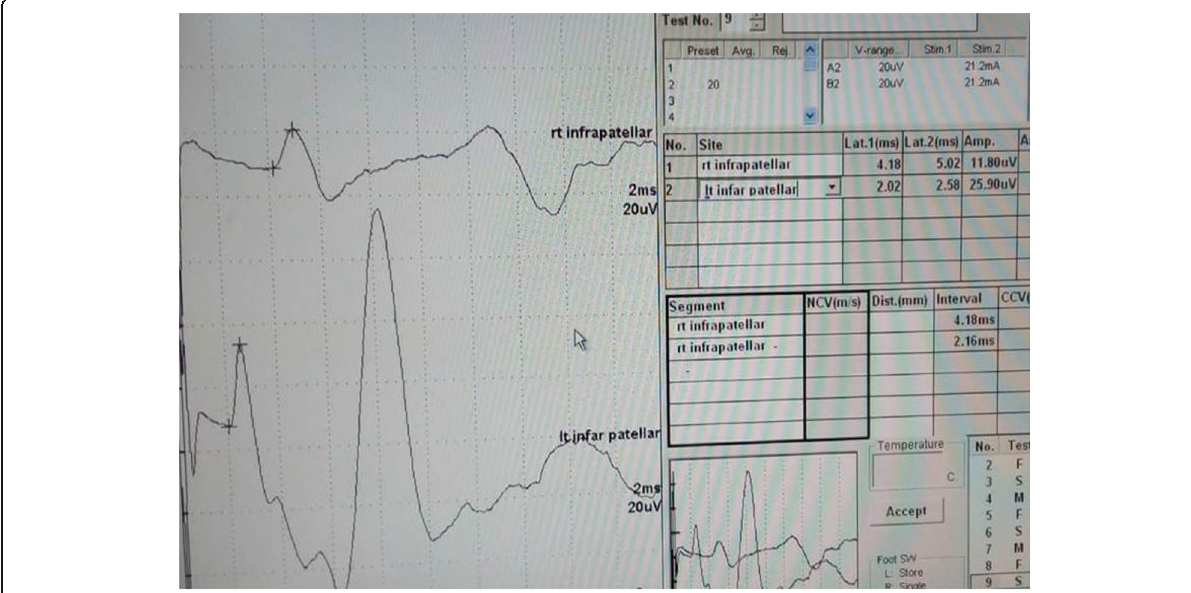
Fig. 1 Electrophysiological parameters of infrapatellar nerve including the peak sensory latency and amplitude, performed in the department of Rheumatology and Rehabilitation by assessment of the sharing rheumatologist using NIHON KOHDEN